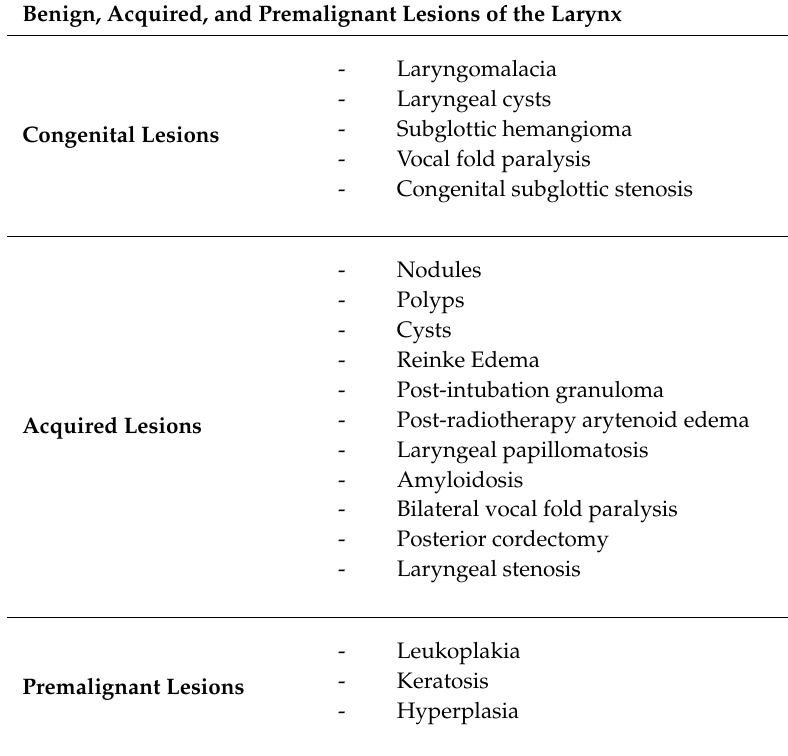
Benign, Acquired, and Premalignant Lesions of the